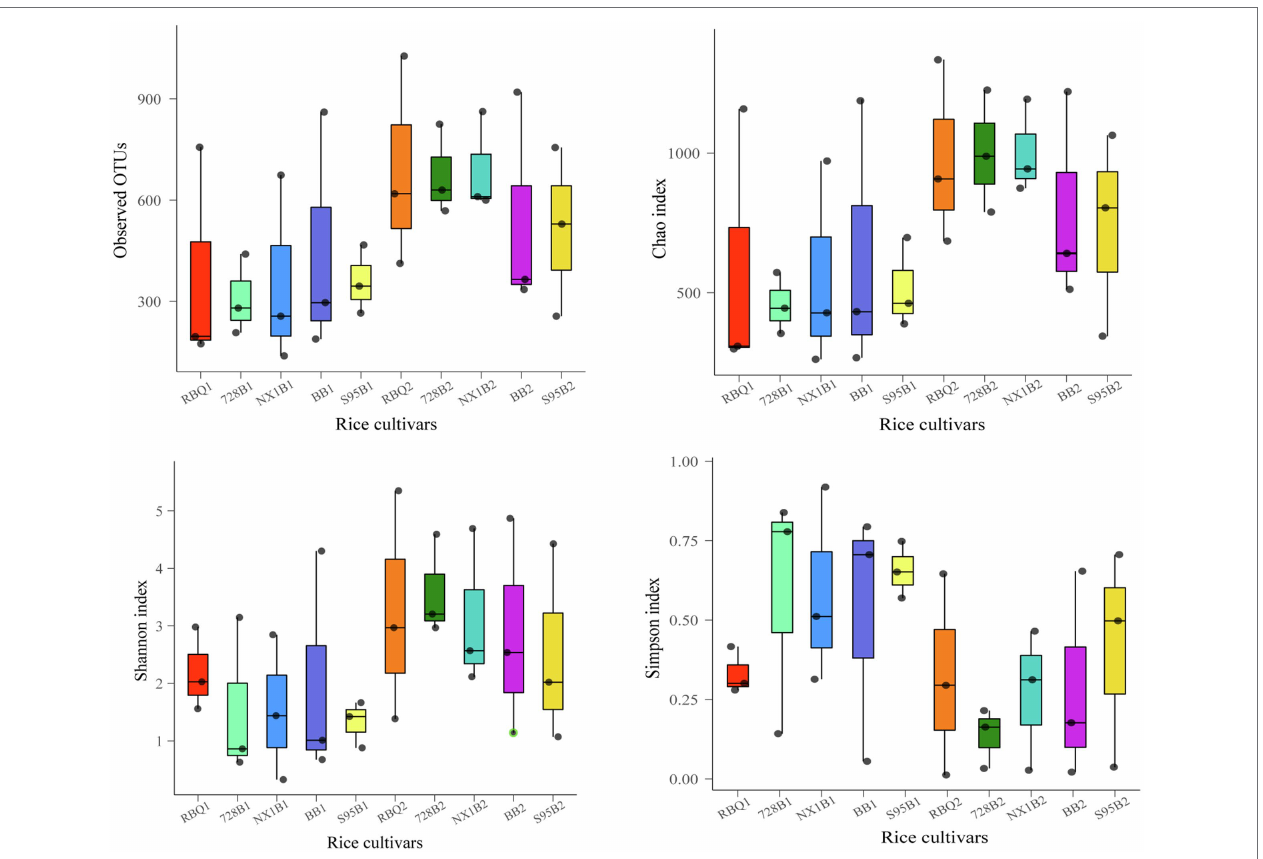
FIGURE 2 | Box plots of α -diversity indices show observed OTUs, Shannon index, ACE index, and Chao1 of five rice cultivars at the vegetative and reproductive stages. The lines at the top, bottom, and middle of the box correspond to the 75th, 25th, and 50th percentiles (median), respectively. The ends of whiskers correspond to the minimum and maximum